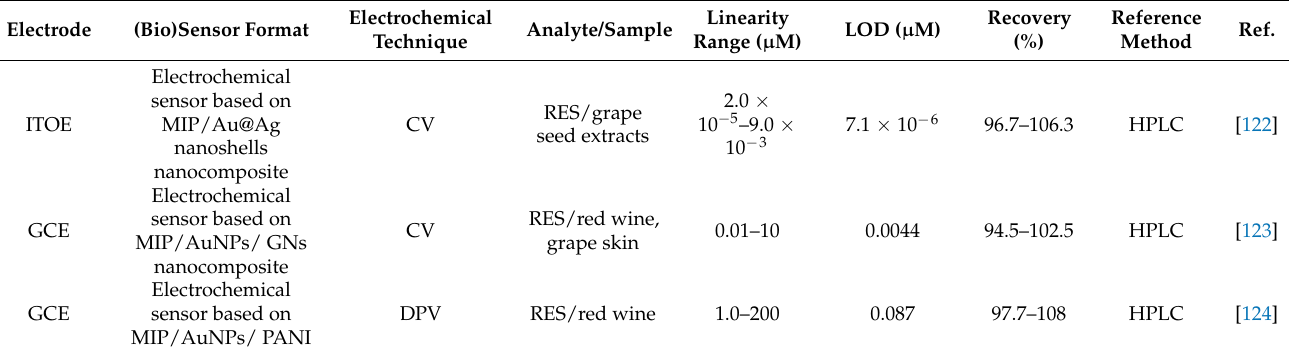
Table 2. Performances of electrochemical sensors for resveratrol